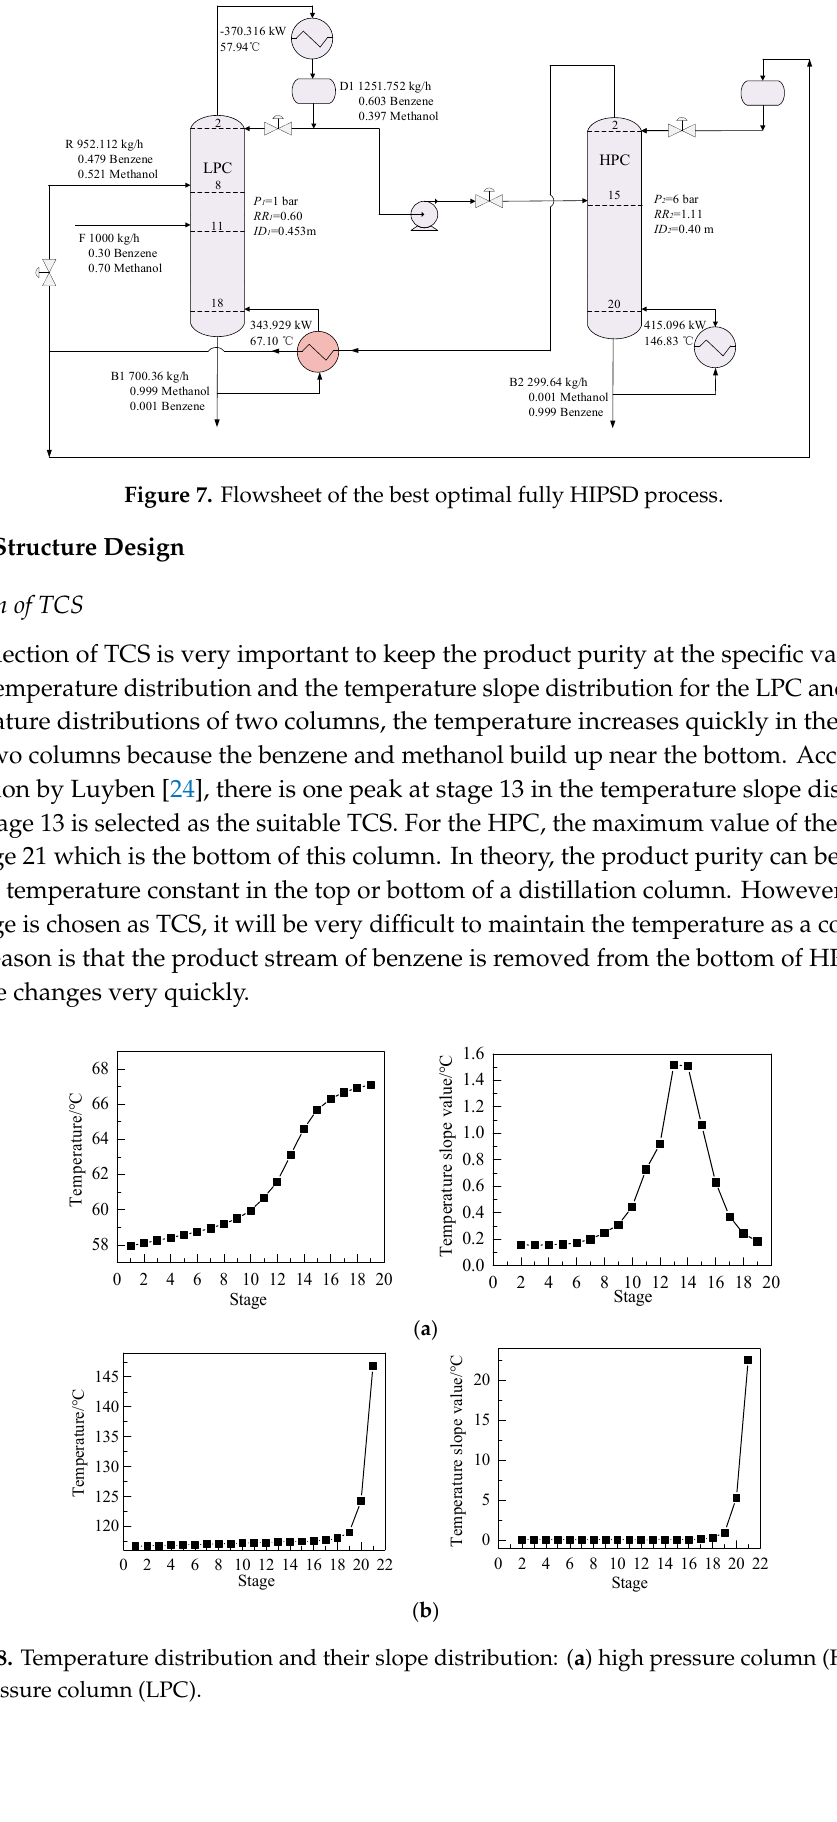
Figure 7. Flowsheet of the best optimal fully HIPSD process.